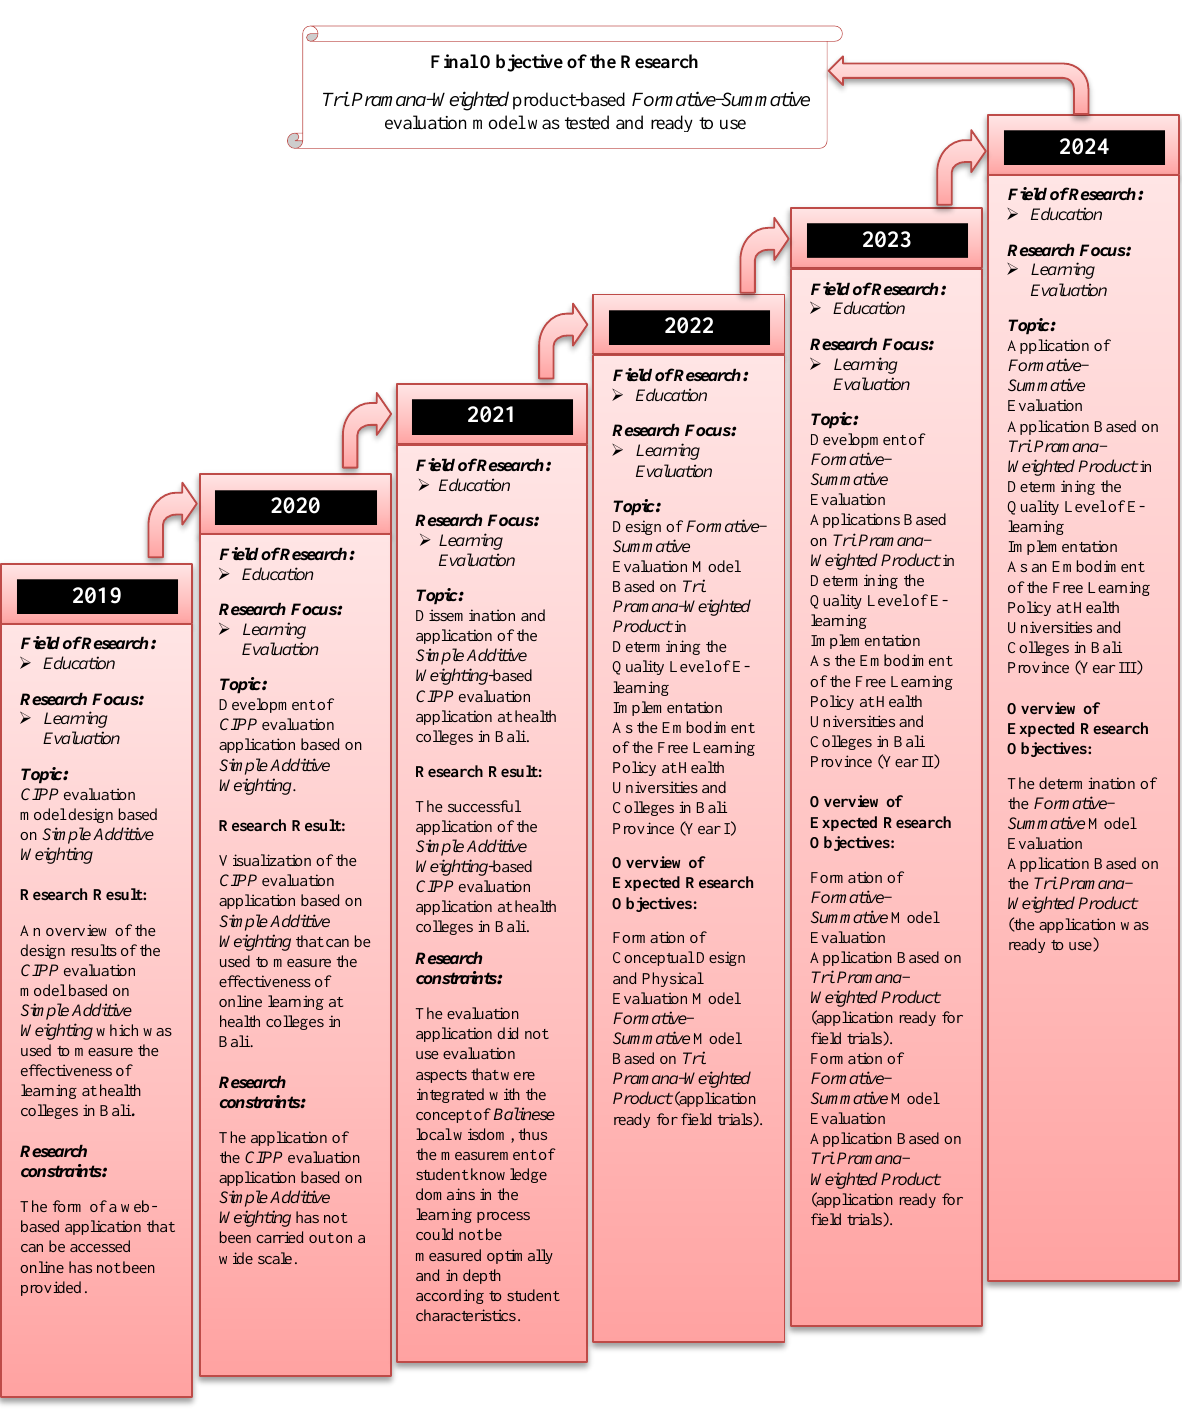
Figure 1. Roadmap for Design of Formative-Summative Evaluation Model Based on Tri Pramana-Weighted